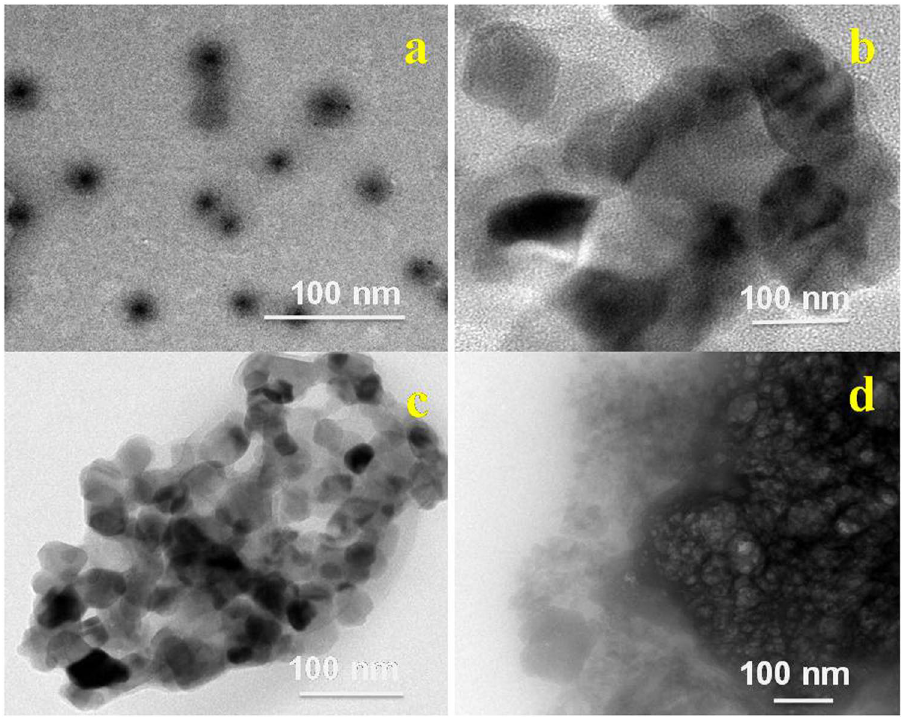
Figure 2. TEM of ( a ) Fe 3 O 4; ( b ) β -CD-EDTA; ( c ) β -CD-EDTA-Fe 3 O 4 ; ( d ) β -CD-EDTA-Fe 3 O 4 /CPT